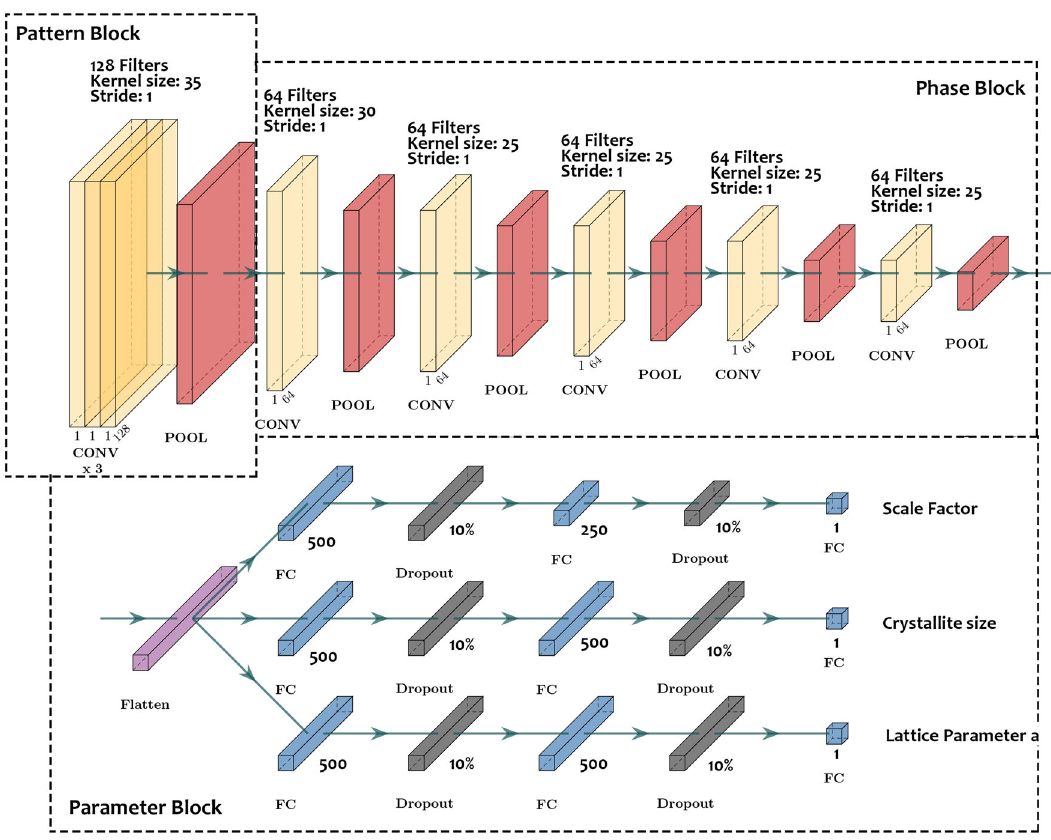
Fig. 1 Regression CNN architecture for Ni phantom experimental system featuring a single phase. CONV represents 1-D convolutional layers, Pool represents max-pooling layers, FC represents fully connected layers, and Dropout represents dropout layers with 10% dropout rate. The network consists of eight convolutional layers, six max-pooling layers, one fl atten layer, nine fully connected layers and six dropout layers in total. There are three routes connected to the fl atten layer which give predictions for scale factor, crystallite size and lattice parameter a, respectively. Each route has three fully connected layers whose scales are shown in the fi gure. The number of fi lters, kernel sizes and the stride of convolutional layers are also given in the fi gure. All max-pooling layers have stride equal to